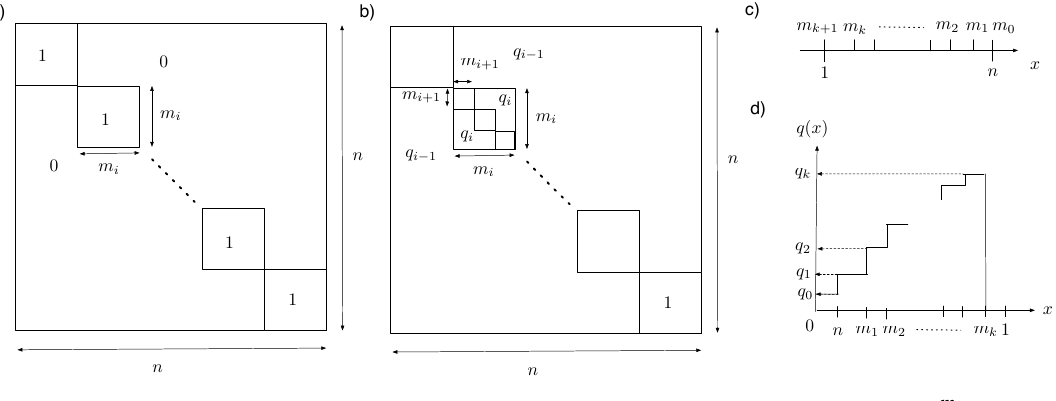
Figure 3: Parametrization of the Parisi’s matrix a) the ’fat’ identity matrix I m i Parisi’s order parameter matrix given by Eq. (143) c) the hierarchy of the sizes m the sub-matrices d) the q ( x ) function with 0 < n <